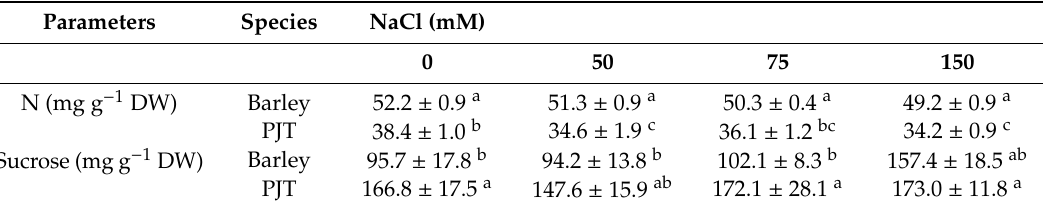
Table 4. Nitrogen (N) and sucrose concentrations in barley and Peucedanum japonicum (PJT) leaves at di ff erent NaCl